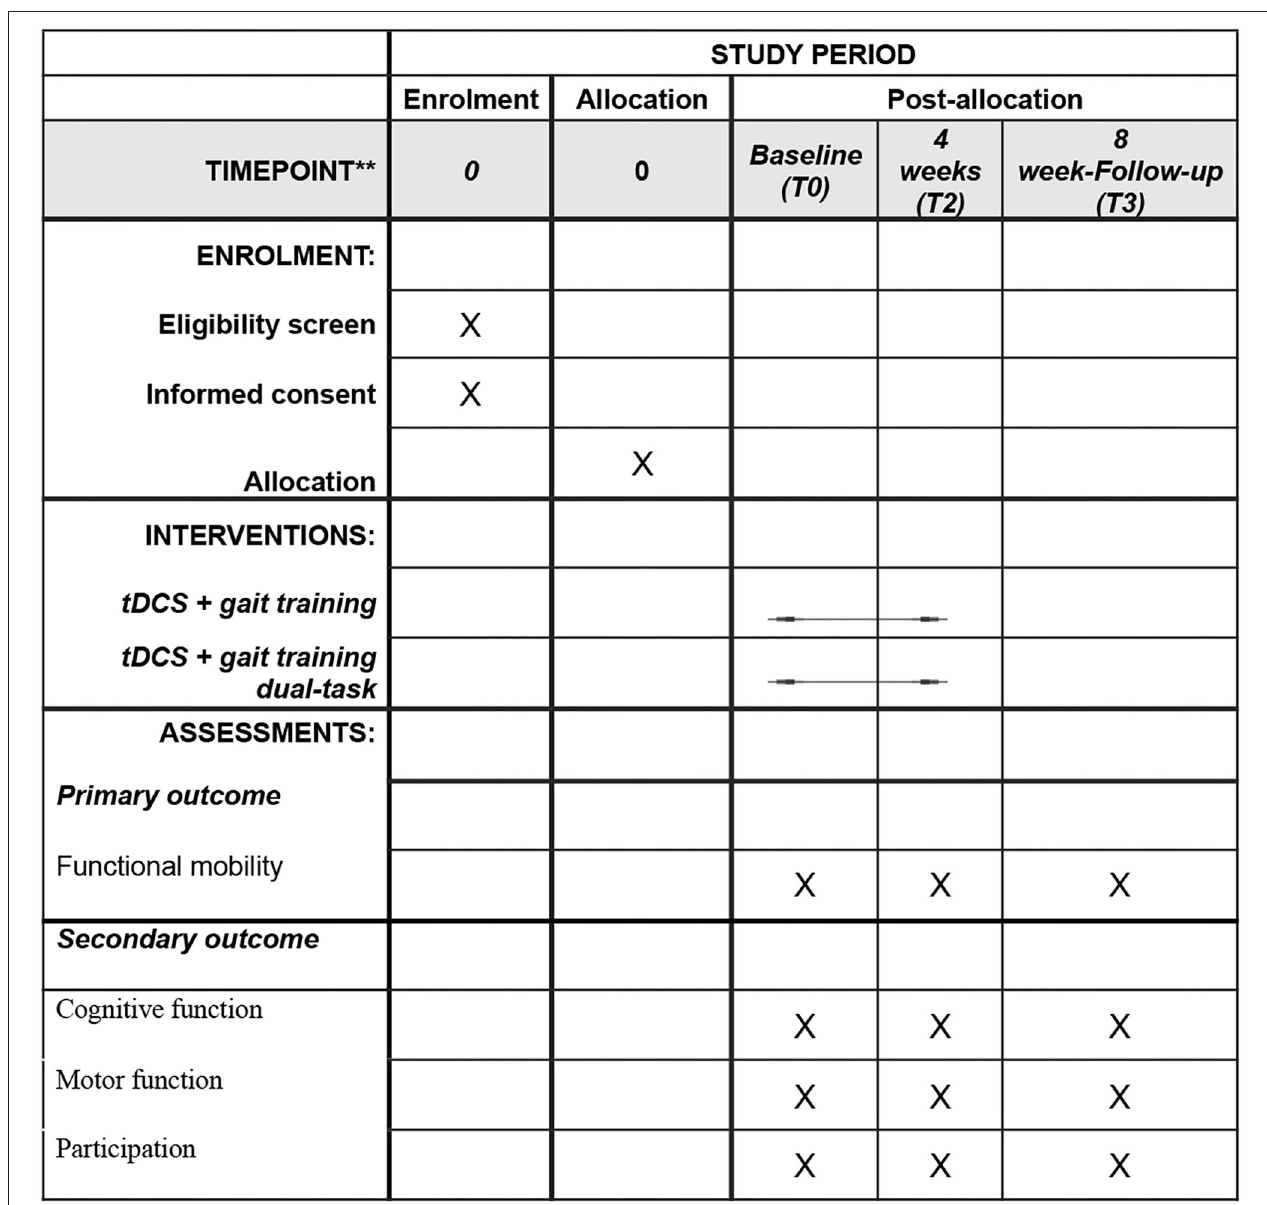
FIGURE 1 | Schedule of enrollment, interventions and assessments demonstrated in the Standard Protocol Items: Recommendations for Interventional Trials